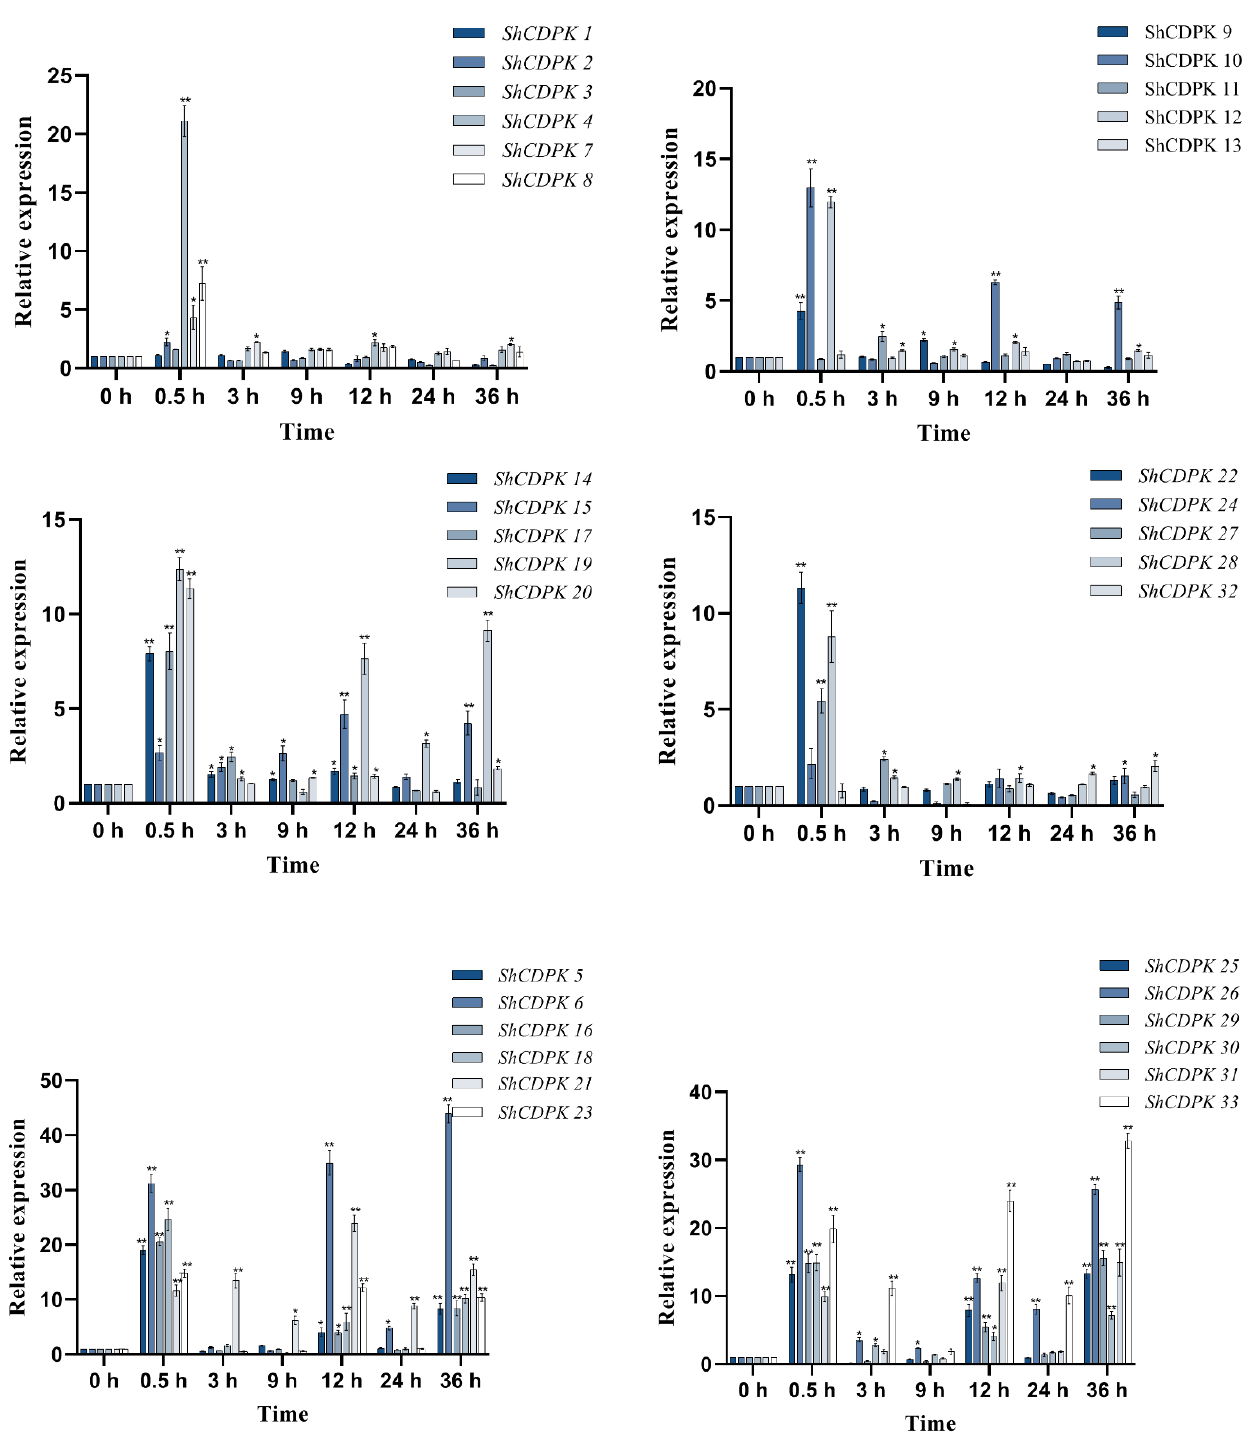
Figure 6. Expression analysis of CDPKs gene in Solanum habrochaites with real-time PCR under Botrytis cinerea stress. Quantitative PCR data are represented as mean ± SEM. ** p < 0.01, * p < 0.05. All date represent mean values for three independent biological replicates.